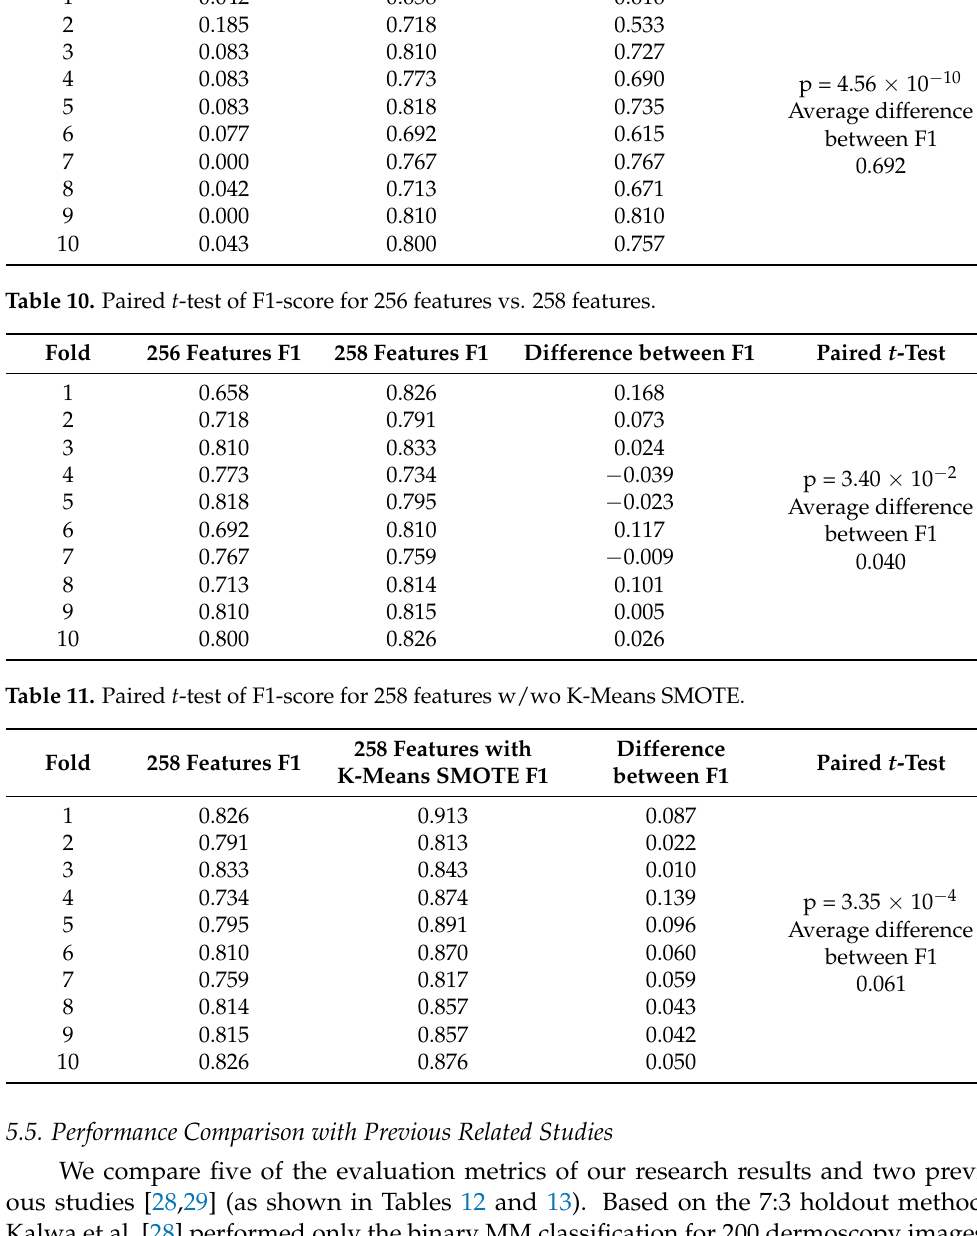
Table 9. Paired t -test of F1-score for 5 Features vs. 256 Features. Fold